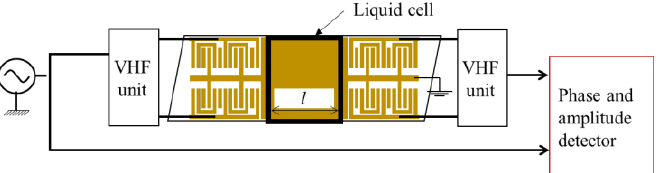
Figure 2. Phase and amplitude measurement system in this study. Channels 1 and 2 were selecting using the very high frequency (VHF) switching unit. The measured system was controlled by the external PC.